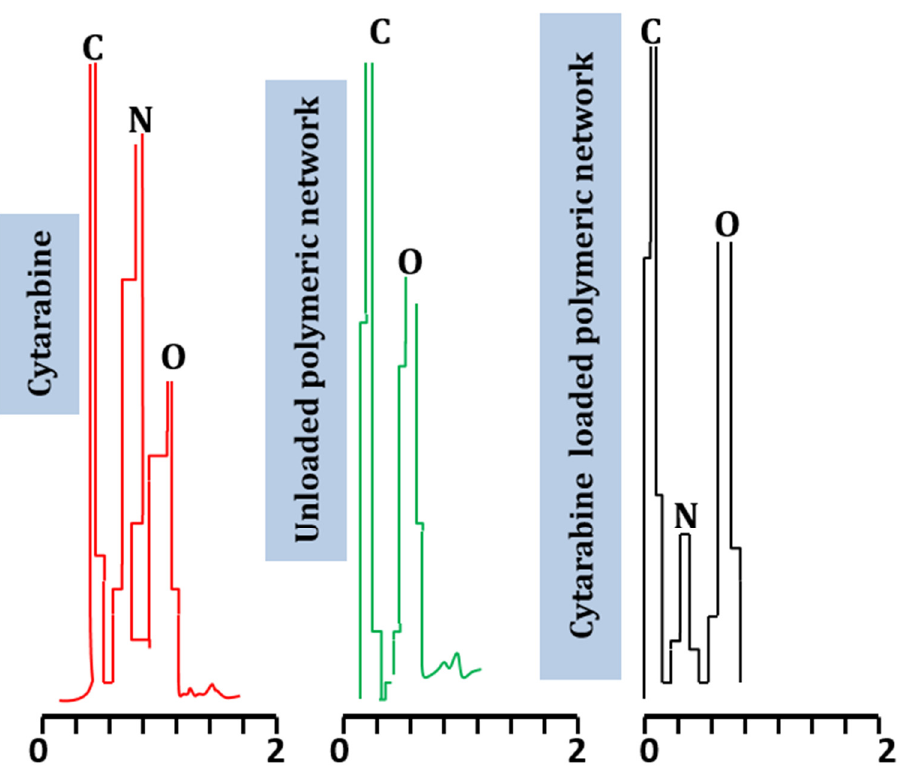
Figure 6. EDX spectra of cytarabine, unloaded network, and cytarabine-loaded network: nitrogen (N), oxygen (O), and carbon (C) .